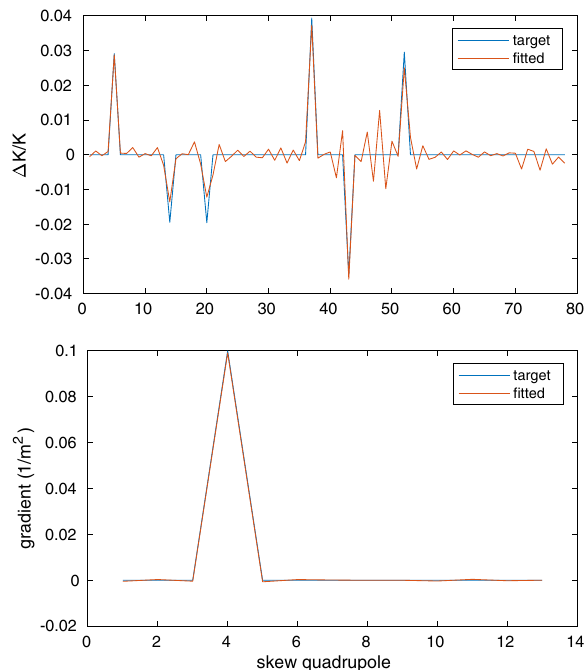
FIG. 10. The dispersion functions of the reference lattice are compared to the fitted lattice. Top, vertical; bottom,